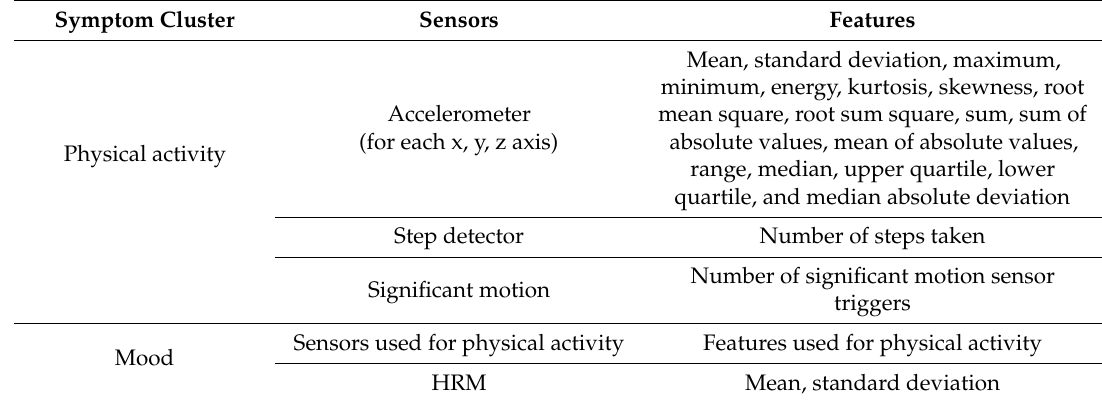
Table 2. List of sensors and features for physical activity and mood level